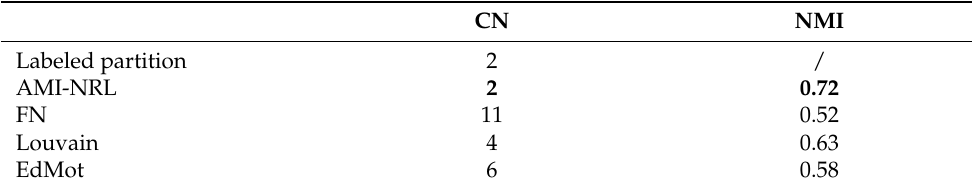
Table 6. Results of AMI-NRL and the other community detection algorithms on Polblogs.